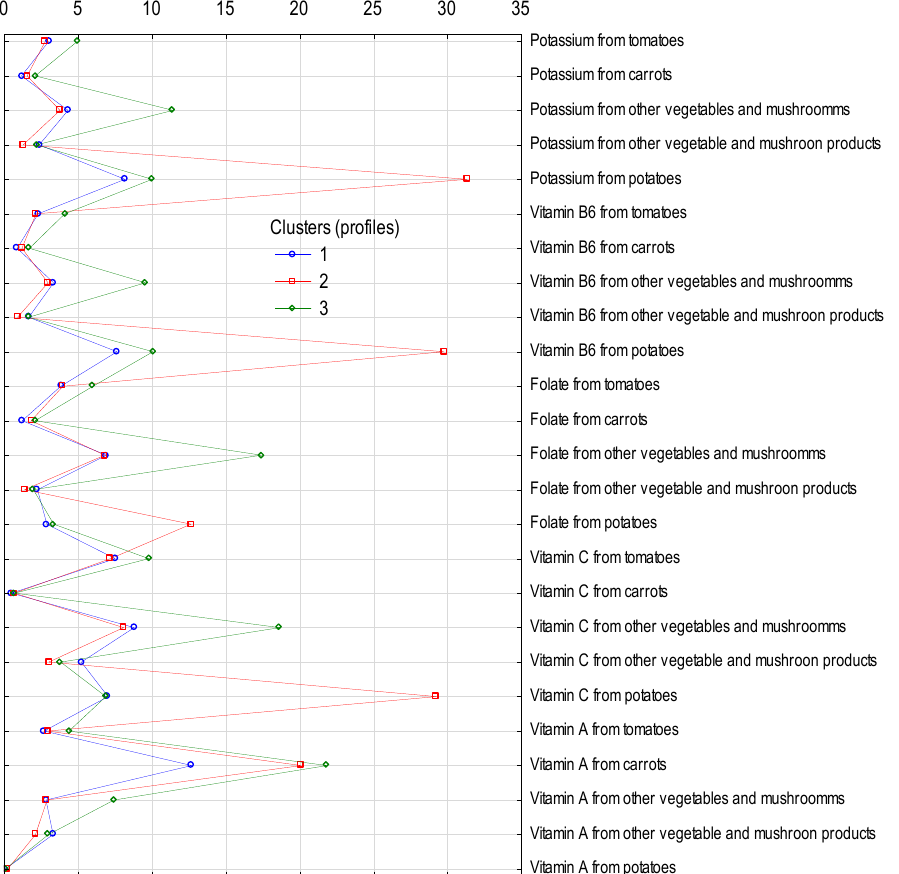
Figure 2. Cluster analysis: percentage contribution of selected nutrients from selected vegetables, potatoes, and their prod- ucts.